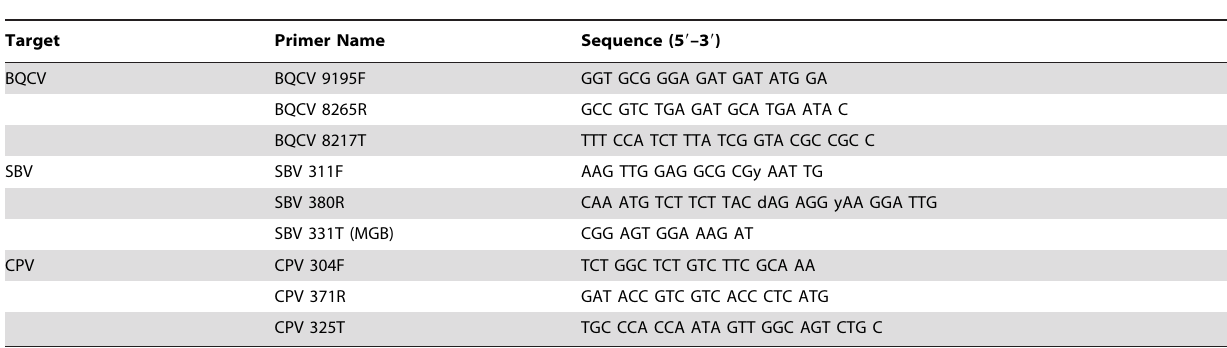
Table 1. List of primers used for virus